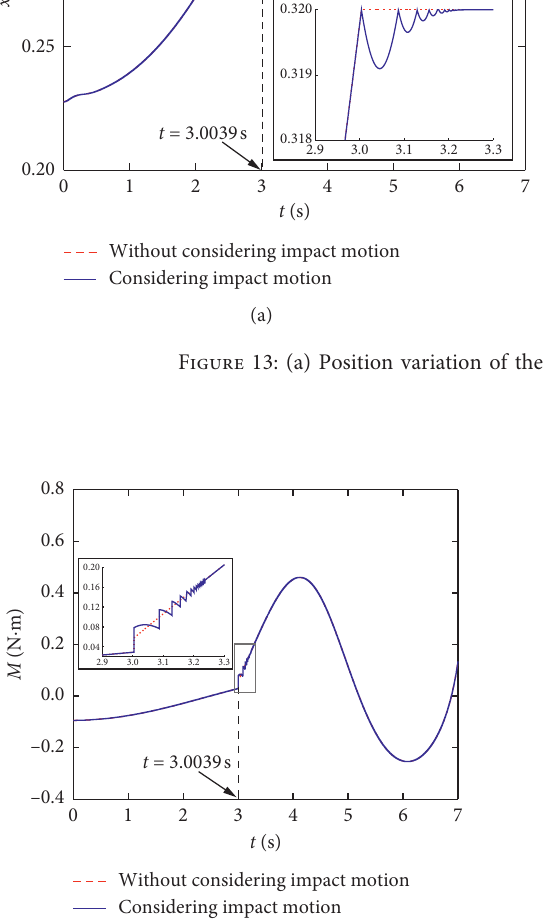
Figure 14: Driven moment variation.